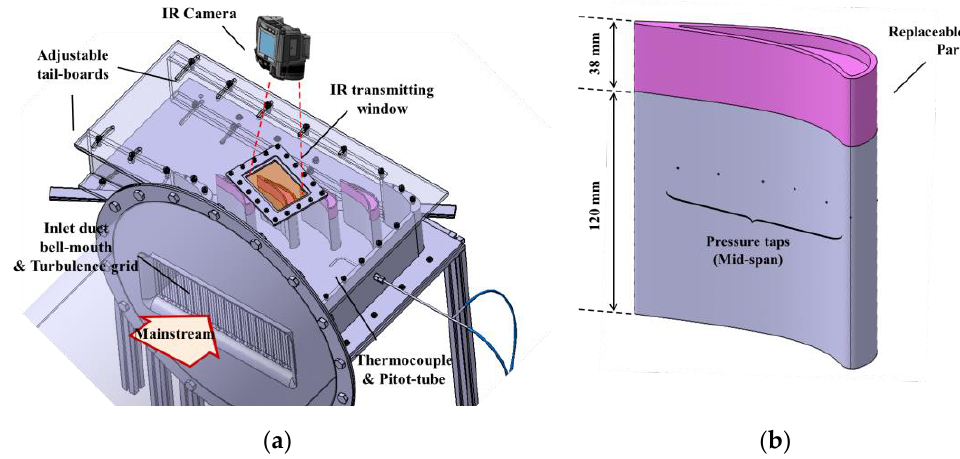
Figure 3. Schematic of test section ( a ) Experimental test setup; ( b ) Heat transfer measurement blade.